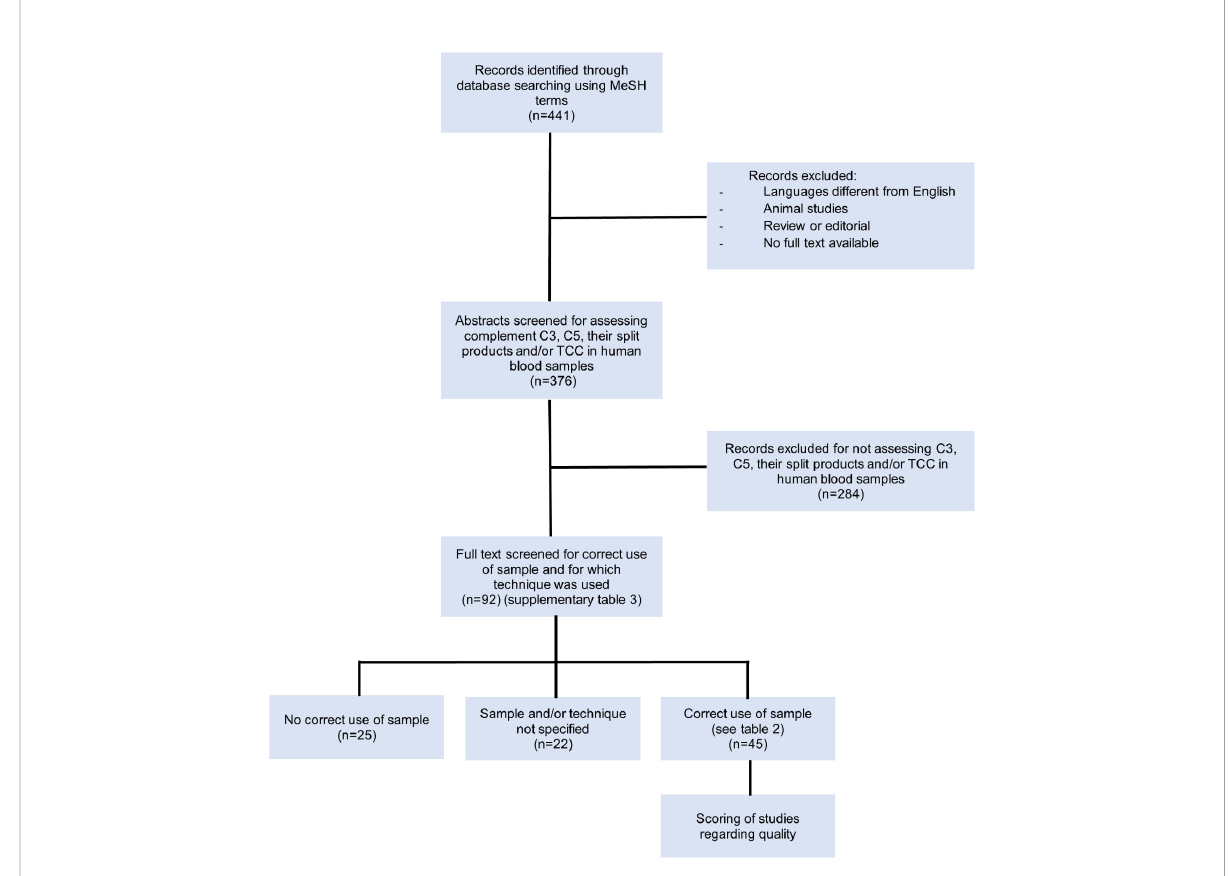
FIGURE 3 Flowchart of the systematic literature search selection